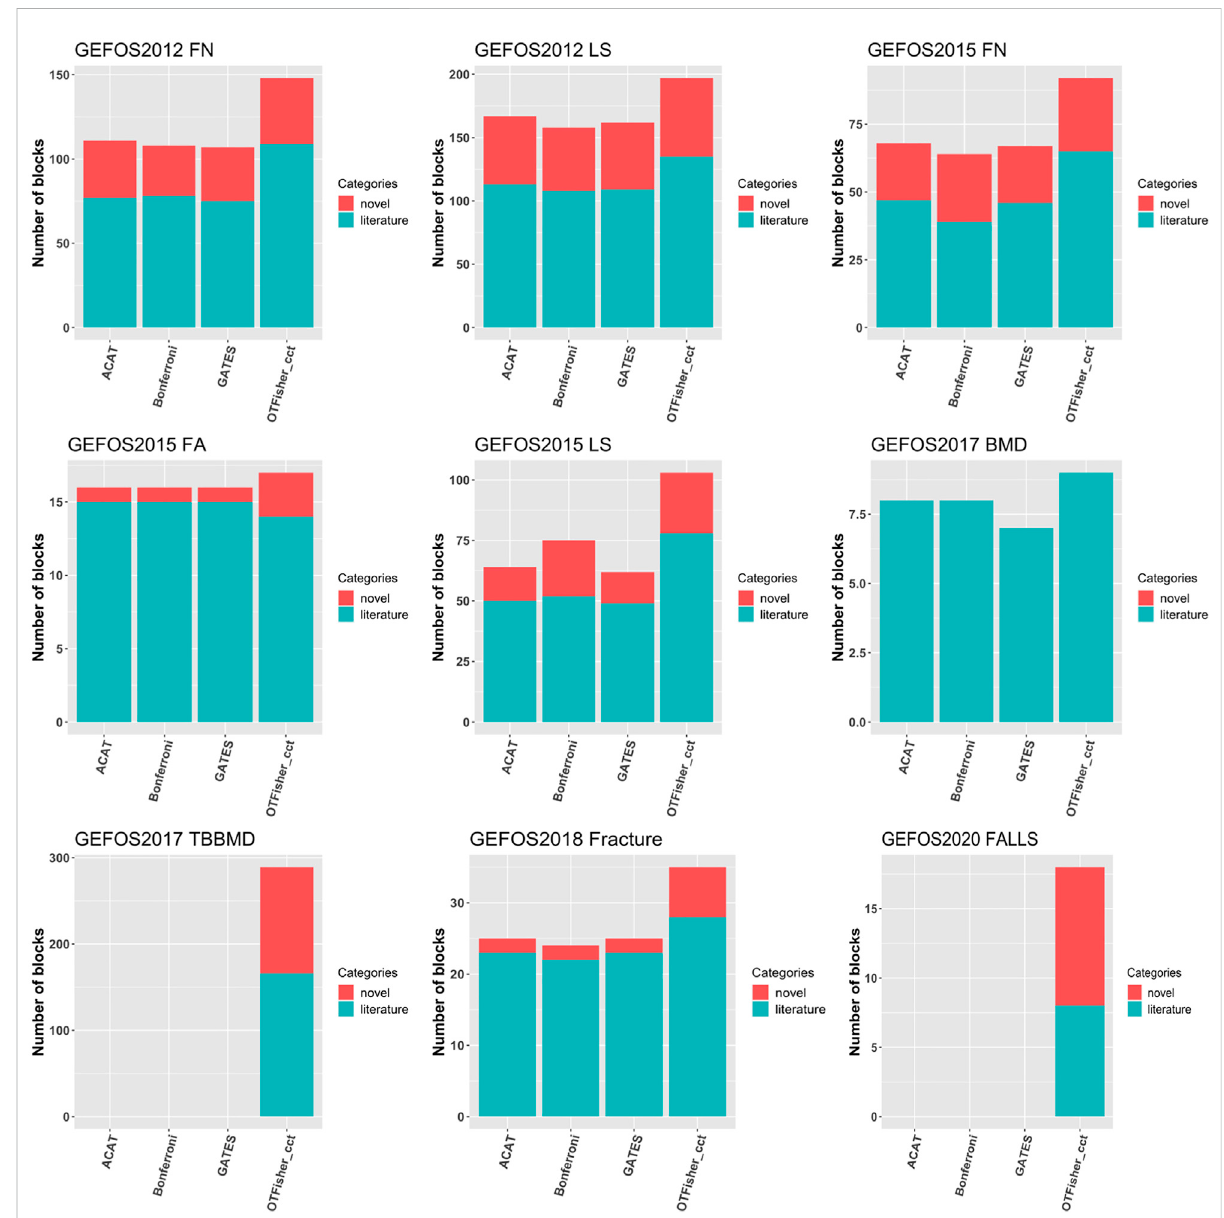
FIGURE 6 Barchartfortop-hitblocksbyvarioustests.LiteratureblocksarethosemappedtoliteraturegenesorcontainingliteratureSNPs.Genome-wide signi fi cantSNPswereremovedfromtestingthedataofGEFOS2017_TBBMD.TherearenodetectionsforACATandGATESforthe2017_TBBMDand 2020_FALLS data because they had no haploblock p -values surpassing the signi fi cance level de fi ned by 0.05 over the number of